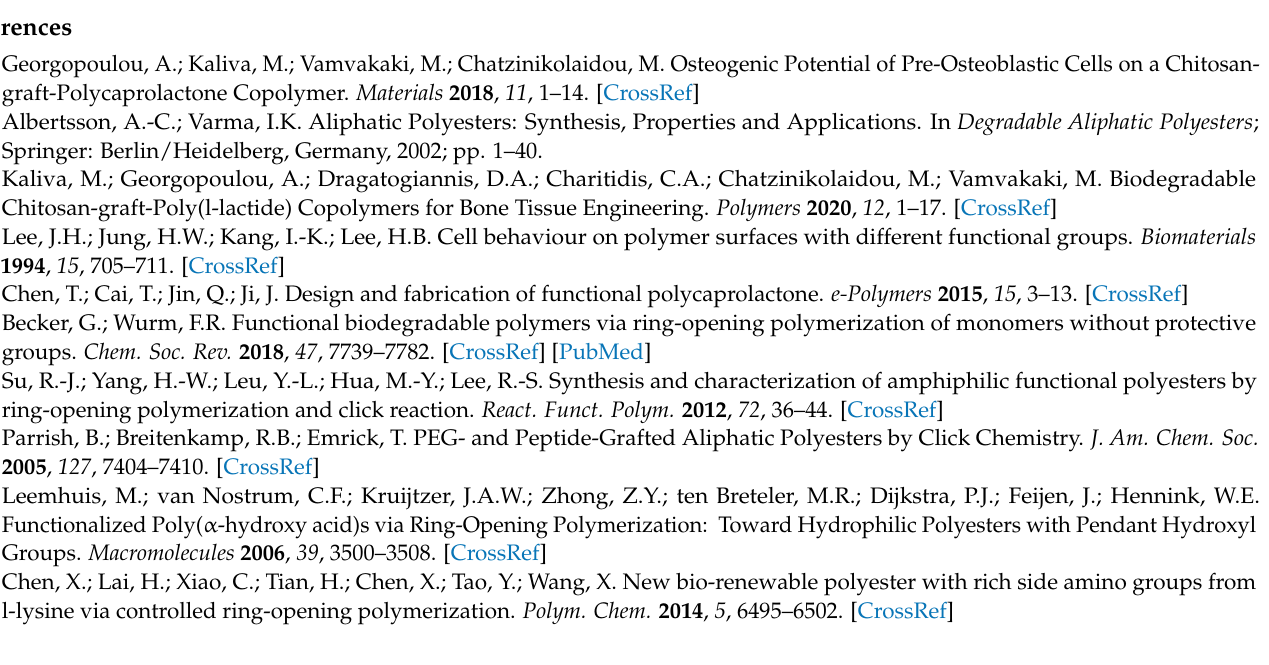
Figure S2: Potentiometric titration curves of the PE-GlycXX copolymers, Scheme S1: Procedure for the thin film preparation, Figure S3: Static water contact angles on the cross-linked thin polymer